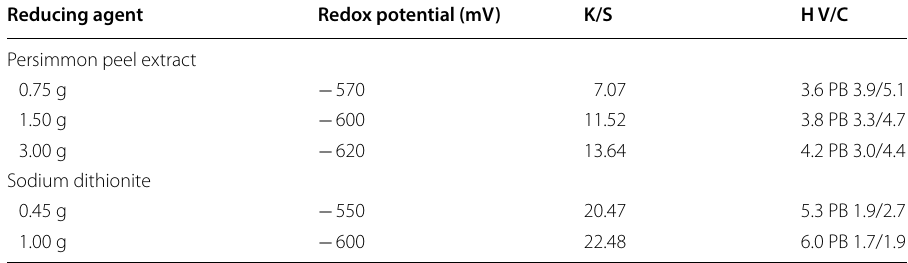
Table 1 Comparison of reducing power of persimmon peel extract and sodium dithionite Reducing agent